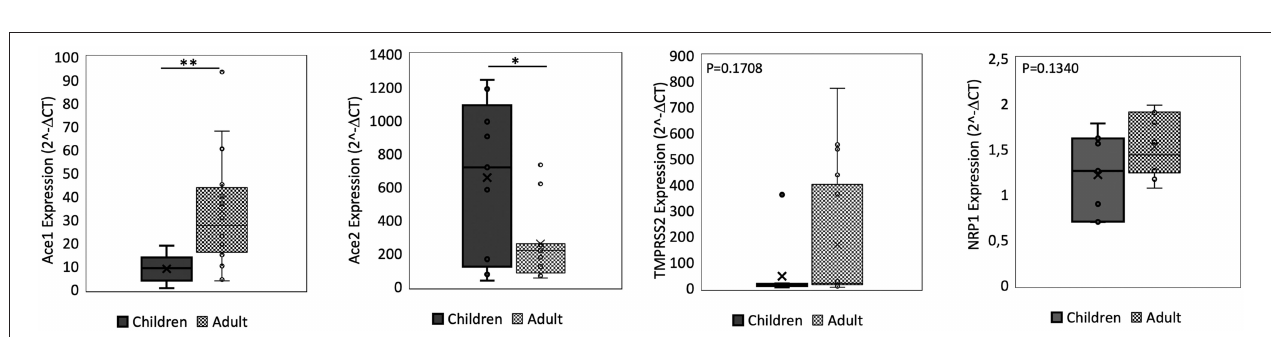
FIGURE 1 | qPCR analysis of Angiotensin I Converting Enzyme ( ACE1 ), Angiotensin II Converting Enzyme ( ACE2 ), Transmembrane Serine Protease 2 ( TMPRSS2 ), and Neuropilin-1 (NRP1 ) genes in nasal epithelium from children and adult subjects. Comparative expression of ACE1 , ACE2 , TMPRSS2 , and NRP1 in nasal epithelium of children ( n = 15) and adult subjects ( n = 15). Data analysis was performed using the comparative threshold cycle (CT) method and expressed as 2 ∧ -delta CT. Gene expression was normalized against the expression of the reference gene hypoxanthine phosphoribosyltransferase 1 ( HPRT ). Data are expressed as median ± SD, the X in the bars indicates mean values. P -value are reported in the graphs; significant differences are indicated as * p < 0.01; ** p < 0.005.